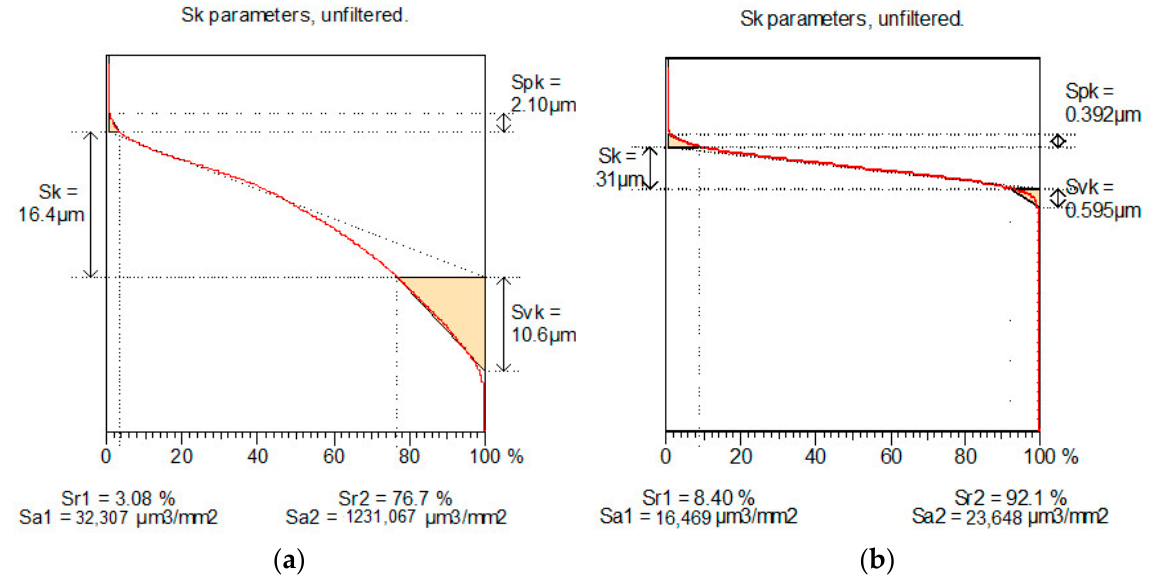
Figure 8. Abbott – Firestone curve( a ) for base surface and ( b ) after burnishing 𝑃 = 60 N , 𝑓 = Figure 8. Abbott–Firestone curve ( a ) for base surface and ( b ) after burnishing P = 60 N, 1000 mm/min (experimental run no. 8). f = 1000 mm/min (experimental run no.